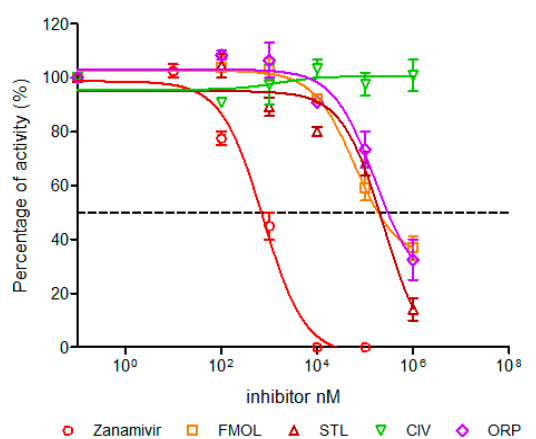
Figure 9. Concentration-activity diagram and corresponding IC 50 values of viral replication inhibition. IC 50 was calculated using GraphPad Prism 6.04. Nonlinear regression analysis was performed to obtain trend lines. Data represent the average ± SD of three independent experiments. The experiment with the molecule AAMOL was not carried out. The color code for the diagram lines of NA inhibition is as follows: red corresponds to zanamivir, orange FMOL, brown STL, green CIV and purple ORP. AAMOL and ORP inhibited enzymatic activity competitively, whereas CIV showed a non-competitive mechanism under millimolar assay conditions. FMOL a ff ected the size and number of plaques at concentrations of 1 mM and 100 µ M. STL completely inhibited at concentrations of 1 mM, losing this e ff ect when diluted to 100 µ M. ORP only lowered the number of plaques at a concentration of 1 mM, but when the concentration was even more lowered it finally lost its inhibitory drug action (Figure 9, Table 2). The detrimental e ff ects on living cells were also evaluated and the numeric outcome of the standard cytotoxicity test was listed in detail in Supplementary Materials (Table S1). CC 50 is the drug concentrations necessary to reduce cytotoxicity or cell viability by 50%. The CC 50 values of ORP were observed in millimolar ranges, which allows us to use higher concentrations without toxic e ff ects, likewise, AAMOL. Its cytotoxicity is lower, since it is metabolized over time as it is a compound based on two amino acids. Both substances constitute optimal candidates to develop new antiviral drugs. The other compounds can be modified to generate products with greater antiviral activities, seeking to reduce their toxic e ff ects at the same